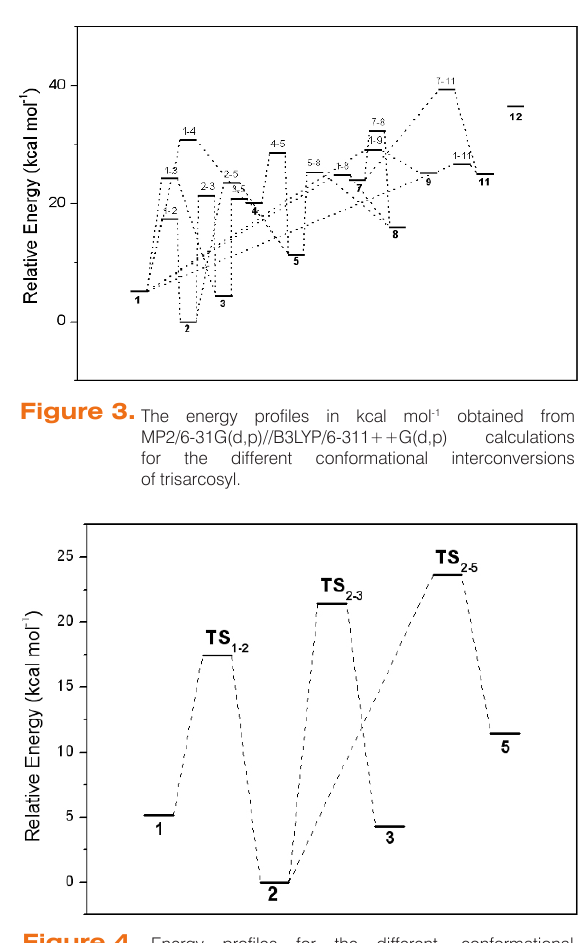
Figure 4. Energy profiles for the different conformational interconversions obtained for conformer